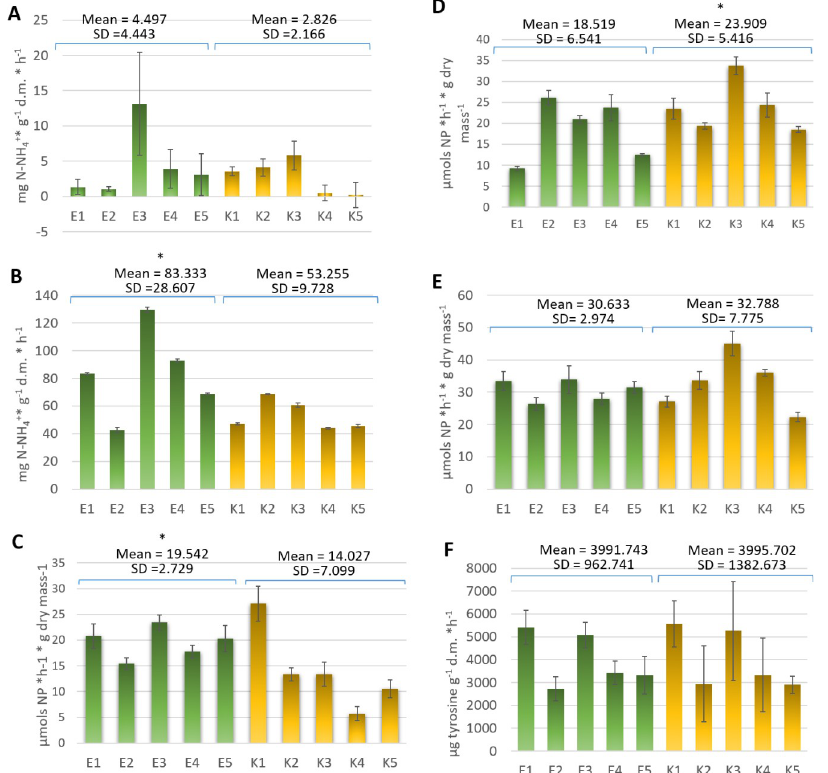
Fig 6. Activity of urease (A), L-glutaminase (B), β -glucosidase (C), acid phosphatase (D), alkaline phosphatase (E), and protease (F) in tested samples derived from organic (green) and conventional (yellow) farming systems.